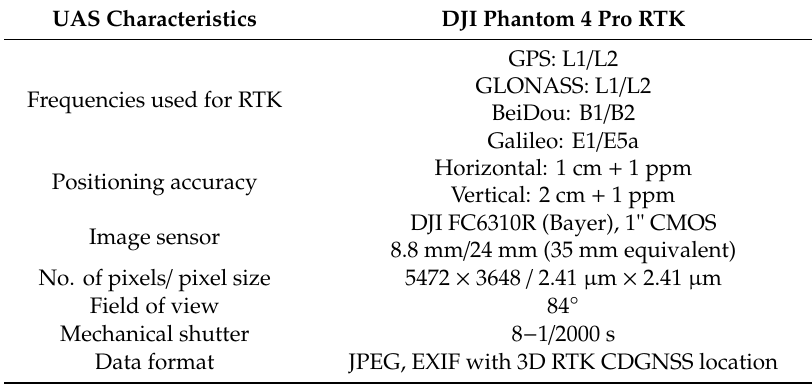
Table 1. Specifications of Da-Jiang Innovations Science and Technology Co., Ltd’s (DJI) real time kinematic (RTK) version of the Phantom 4 Pro according to [49]. Abbreviations: JPEG = Joint Photographic Experts Group; EXIF = exchangeable image file format (EXIF), CDGNSS = carrier-phase di ff erential global navigation satellite system.